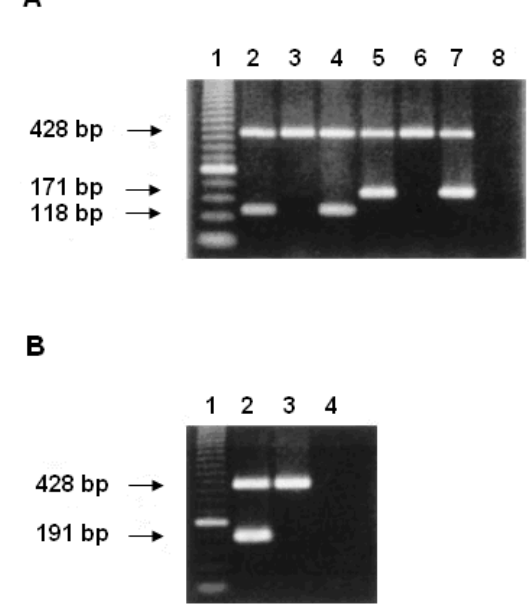
Fig. 1 – Example of HNA-1a, -1b genotyping determination by PCR- SSP. The human growth hormone PCR product (428 bp) is present in all reactions. (A) Lane 1 represents the 50 bp DNA ladder; Lanes 2 and 4: 118 bp PCR product obtained with HNA-1a primers; Lanes 5 and 7: 171 bp PCR product obtained with HNA-1b primers; Lanes 2 and 3: HNA-1a (+/+) homozygous person; Lanes 4 and 5: HNA-1a (+/–) heterozygous subject; and Lanes 6 and 7 show a HNA-1b (+/+) homozygous person; Lane 8 represents the negative control. (B) Lane 1: 50 bp DNA ladder; Lane 2: PCR-SSP positive for the FCGR3B*3 allele (HNA-1c); Lane 3: HNA-1c negative reaction; Lane 4: negative control (Kuwano et al.